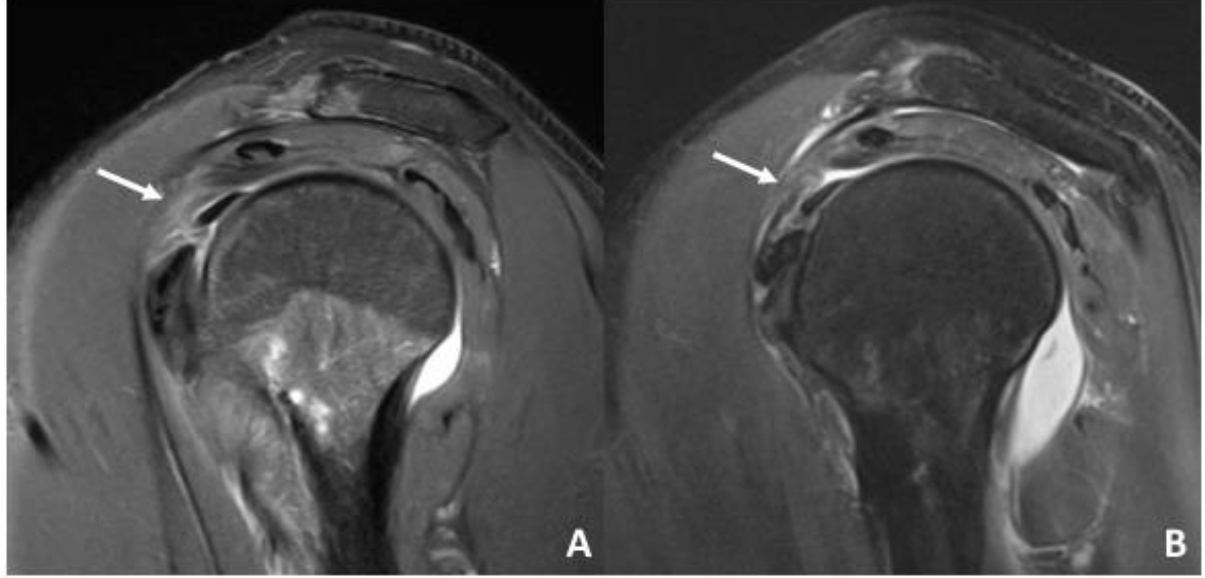
Figure 1. Sagittal IM-weighted TSE sequence with spectral fat saturation. ( A ) Intact biceps pulley in a 26-year-old patient after anterior shoulder dislocation with normal discrimination of the sGHL (white arrow) and CHL. ( B ) Insufficient biceps pulley on a 32-year-old patient after shoulder dislocation due to a tear of the sGHL (white arrow). Caudal displacement of the LHBT is seen at the middle of the rotator interval. Note the joint effusion in both patients which causes an arthrographic effect and helps with the discrimination of anatomical structures.